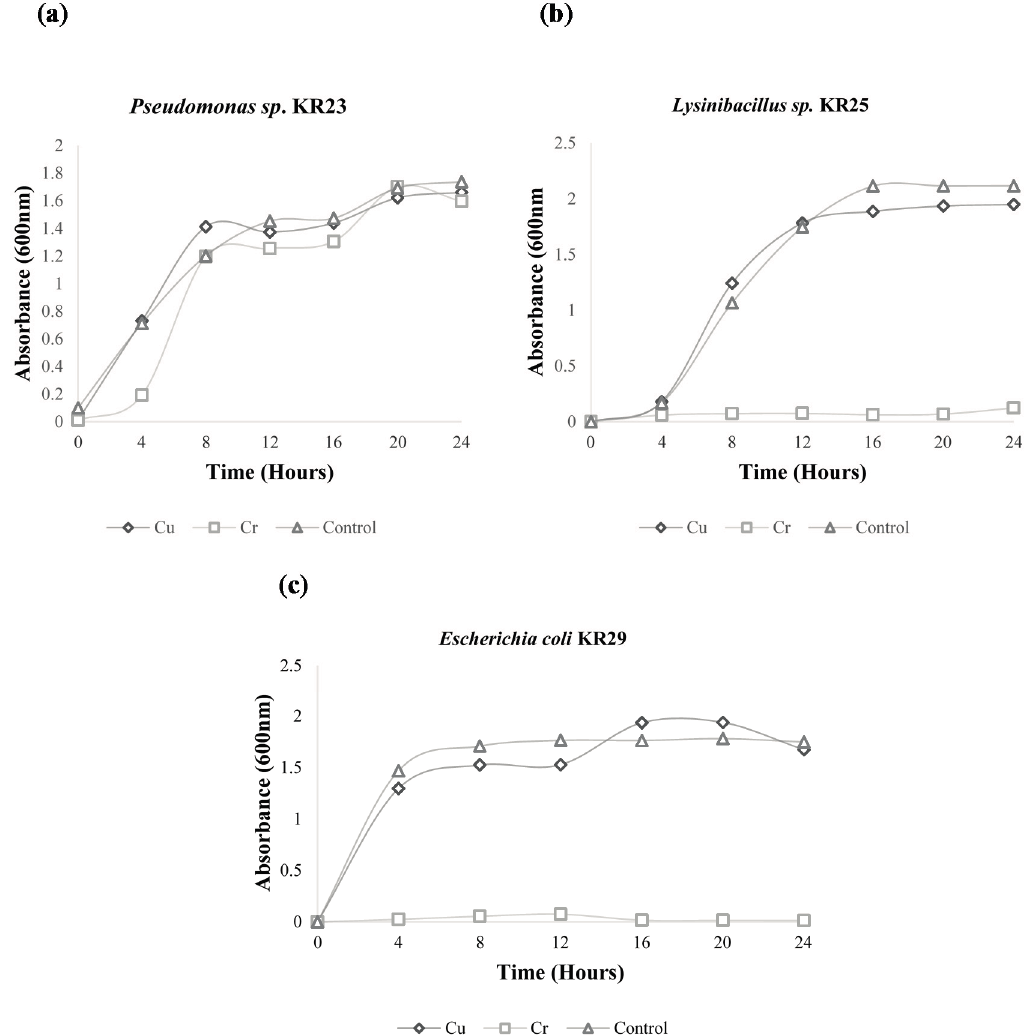
Figure 1. Growth curves of ( a ) Pseudomonas sp. KR23; ( b ) Lyisnibacillus sp. KR25; ( c ) E. coli KR29.